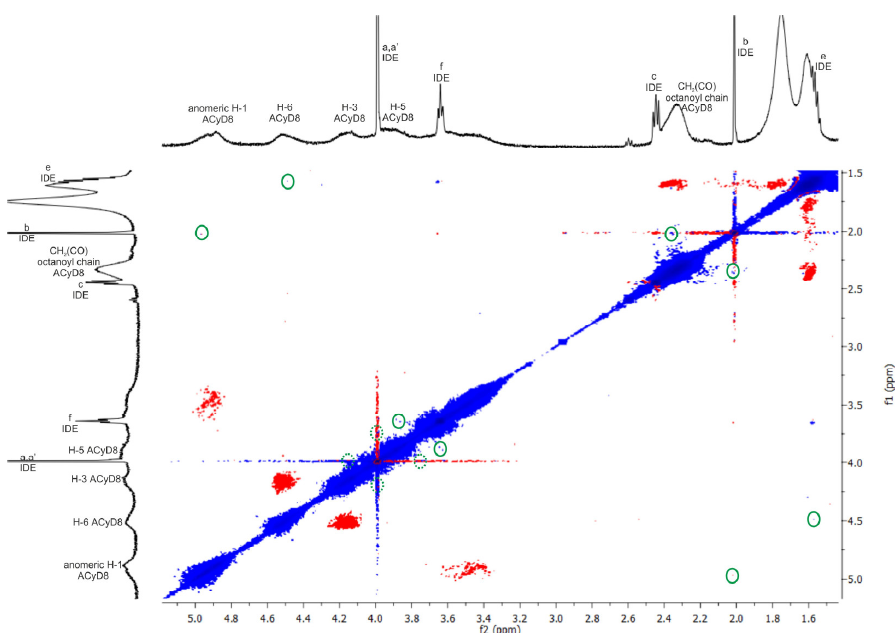
Figure 5. The 2D ROESY spectrum of IDE/ACyD8 complex (CDCl 3 , at 25 °C). Inter- and intra- molecular interactions can be observed; only the cross-peaks of interest were circled in green. Dotted green circles identified cross-peaks slightly overlapped with the diagonal. Blue and red color repre- sented negative- and positive-phase signals, respectively. Lowercase letters a – f were used for IDE proton assignment (see Figure 4).